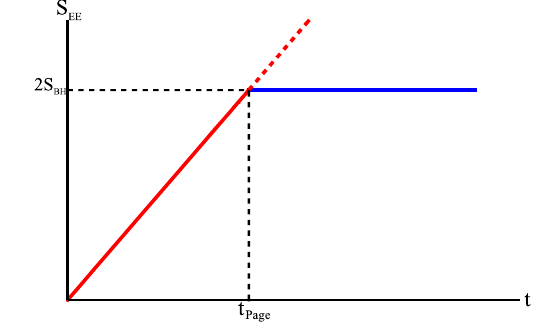
Fig. 3 The page curve for eternal GHS black holes. The red dash line represents the entropy without island while the blue solid line stands the saturation value of the entanglement entropy by considering the island